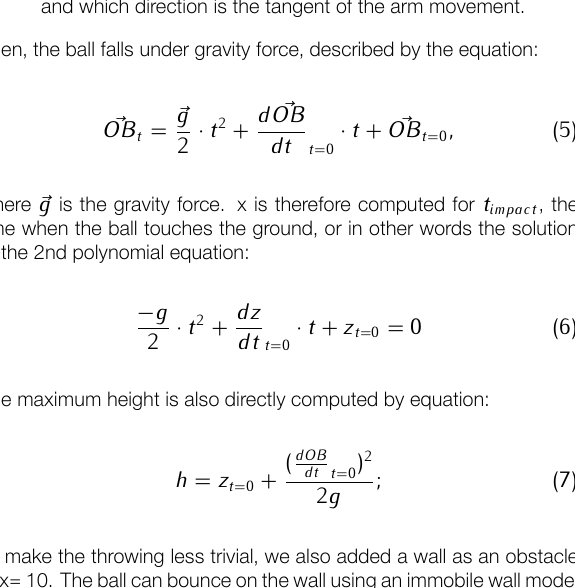
. T is partitioned in regions R R and R 2 3 T 1 ⊂ ,T 2 ⊂ T 3 ⊂